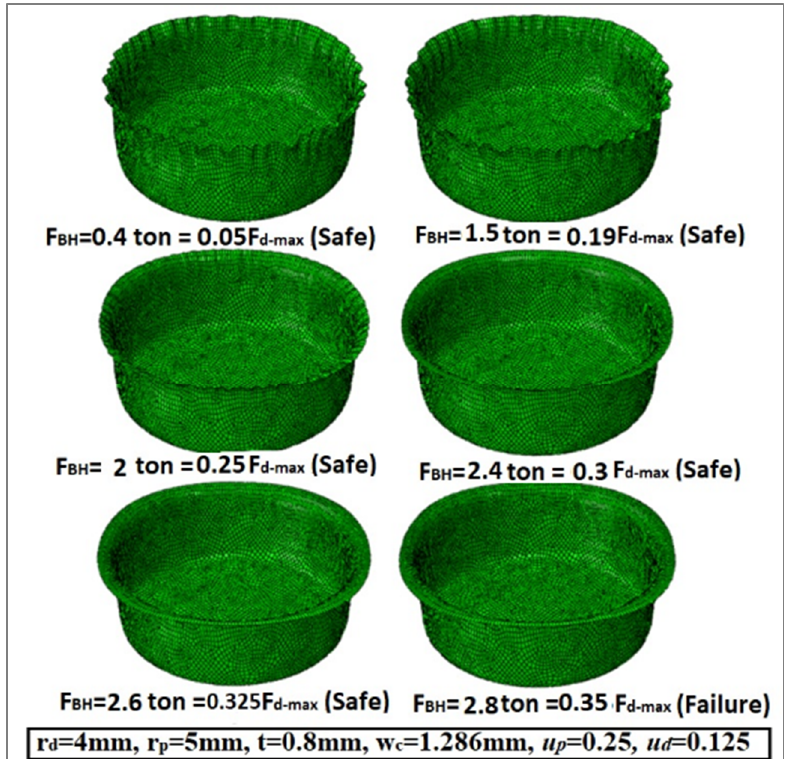
Figure 8. Variation in wrinkling formation as a function of blank holder force ( F BH ) and maximum deep drawing force ( F d-max ) at μ h = μ d = 0.125.